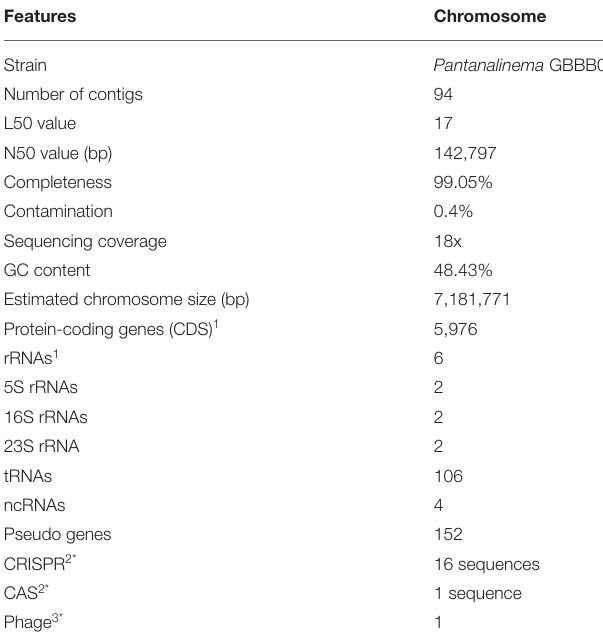
TABLE 1 | Genome features of Pantanalinema